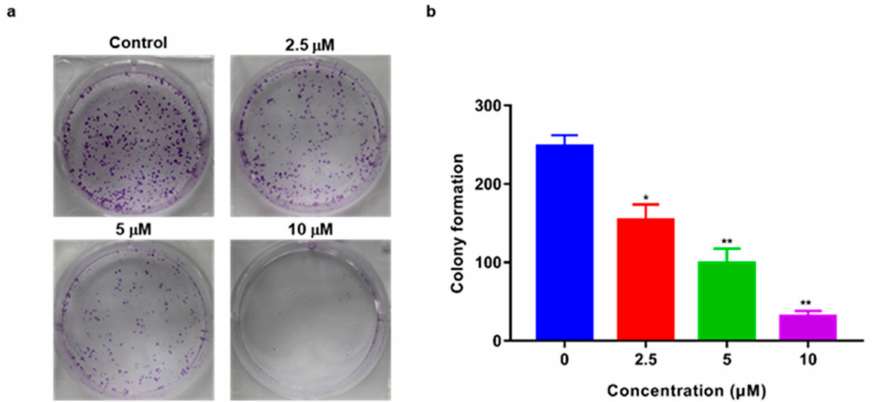
Figure 2. ( a ) Colony formation results of MDA-MB-231 cells cultured with TSC-3C ; ( b ) Bar graph of colony formation; The data are expressed as the means ± SD from three independent experiments. * p < 0.05 vs. the control group, ** p < 0.01 vs. the control